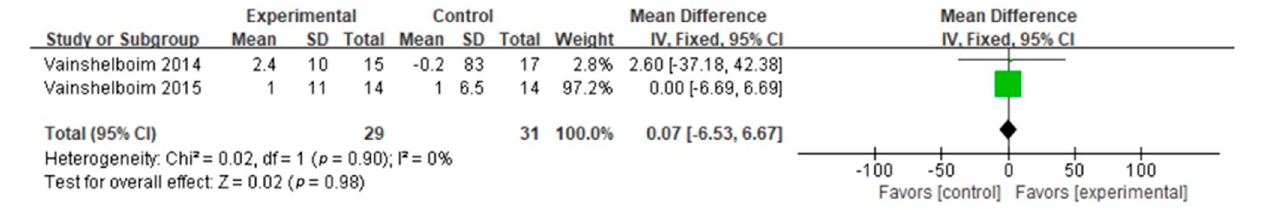
Figure 6. TLC% pred.